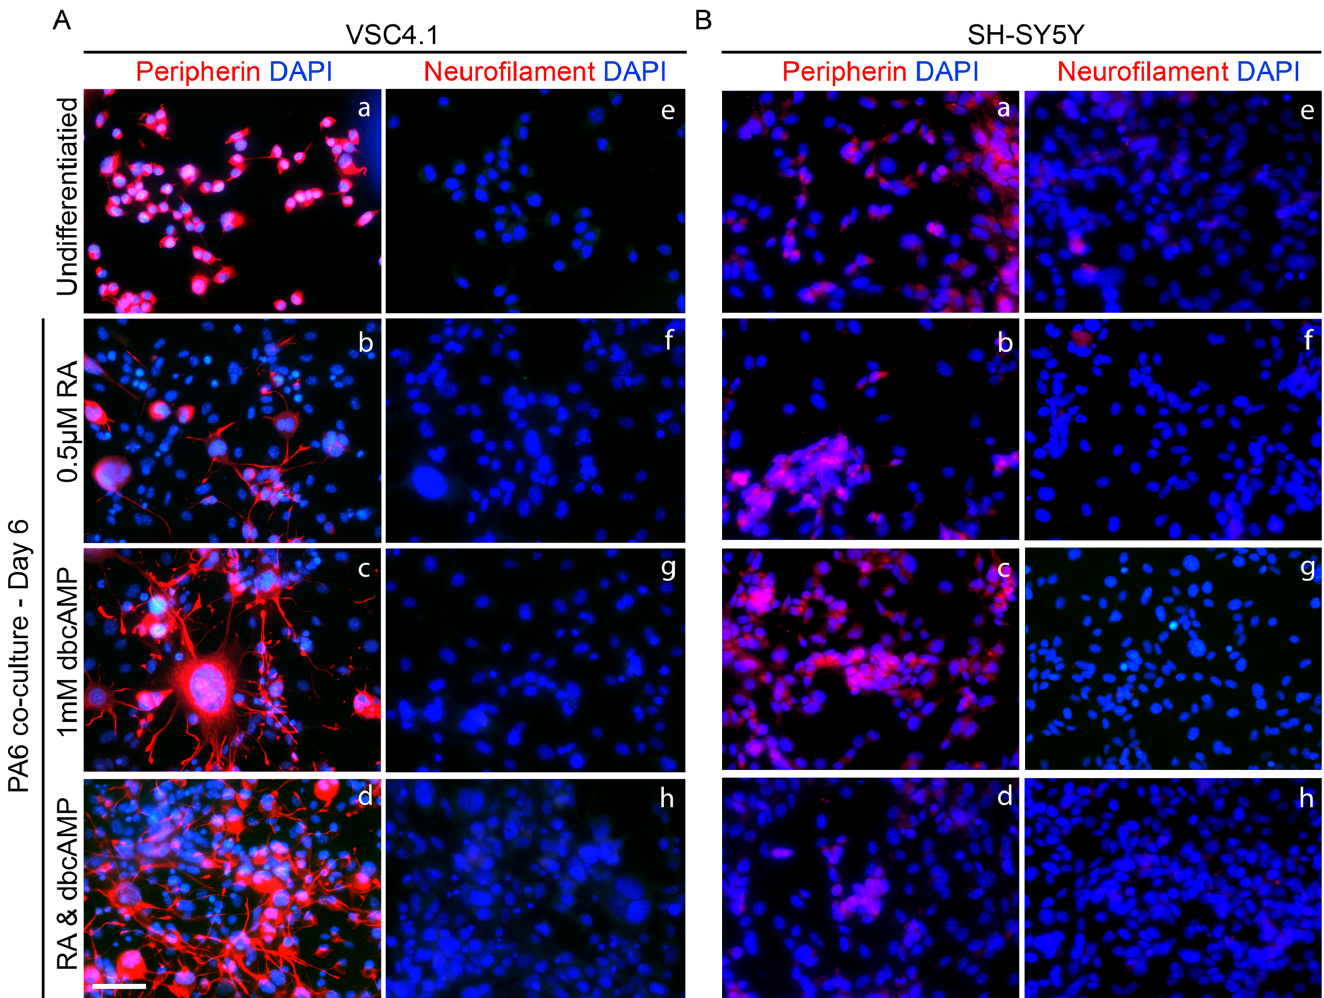
Fig 1. Optimisation of conditions for differentiation of SH-SY5Y and VSC4.1 on PA6. (A) Undifferentiated VSC4.1 have very short peripherin positive processes (a) but not neurofilament (e). Differentiation on PA6 results in extension of peripherin positive neurites on day six (b,d). RA and dbcAMP combined with PA6(c,g) promote extensive neurite outgrowth when compared to either alone (b,f or c,g). No neurofilament staining is seen under any condition. (B) Undifferentiated SY5Y do not express peripherin or neurofilament while undifferentiated or after differentiation on PA6 with 0.5 μ M RA, 1mM dbcAMP or both combined (a-d). Scale bar 50 μ